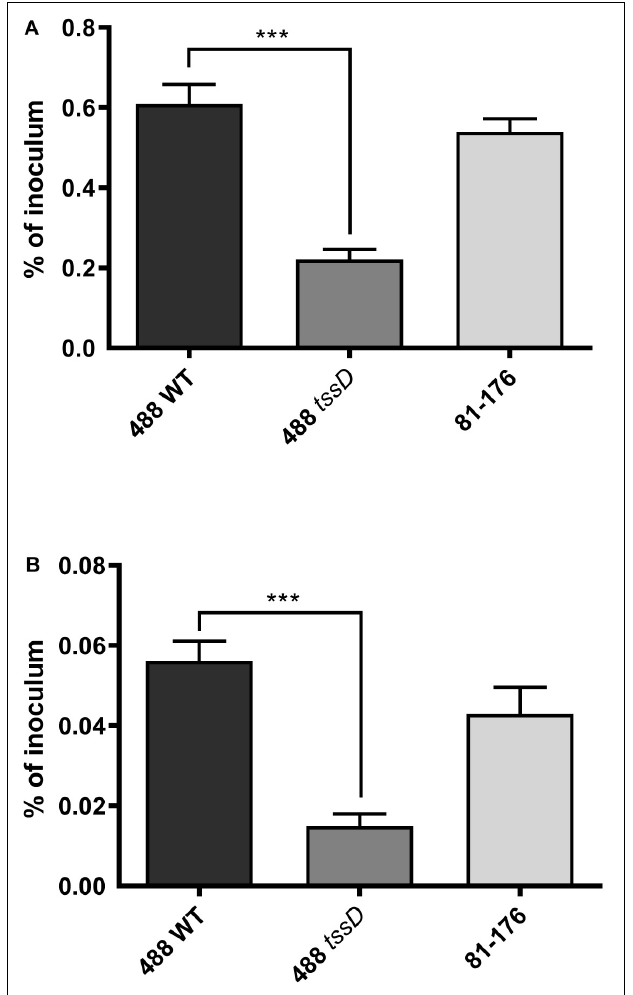
FIGURE 6 | Interactions with and invasion of primary chicken intestinal cells with the 488 wild-type strain, 488 tssD mutant or 81–176 wild-type strain. Primary chicken intestinal cells were infected with C. jejuni strains at a MOI of 1,000:1. (A) For interaction assays, infected monolayers were washed with PBS and treated with 0.1% (v/v) Triton X-100. (B) For invasion assays, infected monolayers were washed with PBS and treated with gentamicin (400 µ g/ml) for 2 h at 37 ◦ C. Cells were then washed with PBS and treated with 0.1% (v/v) Triton X-100. For both experiments, serial dilutions were then performed and the CFUs/ml counted. Asterisks denote a statistically significant difference ( ∗∗∗ p ≤ 0.001).